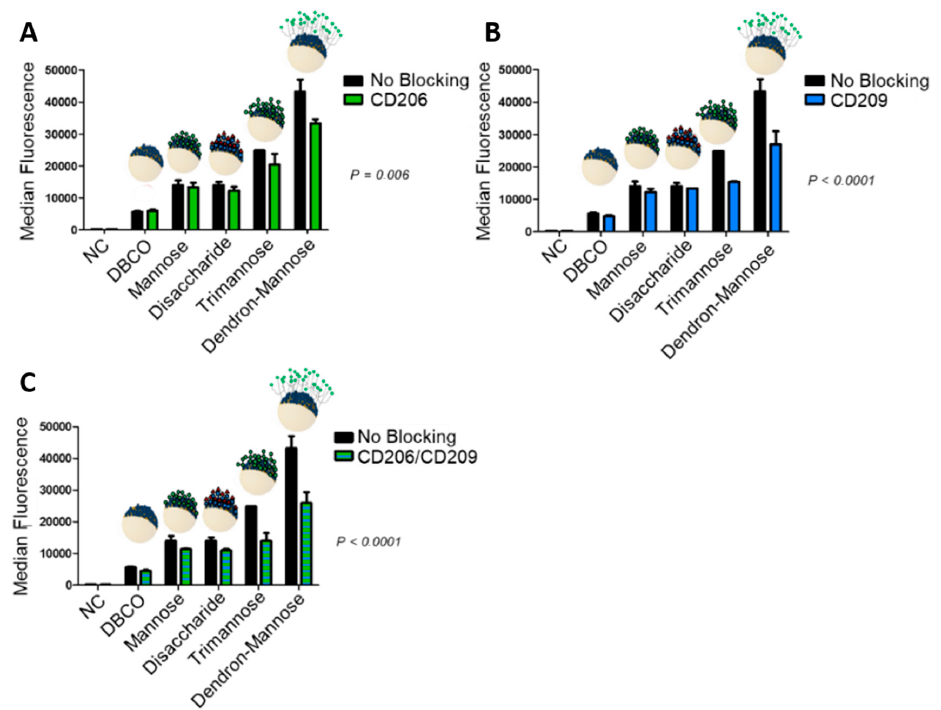
Figure 3. Uptake and blocking experiments of HES nanocapsules, decorated with carbohydrates into human dendritic cells (hDCs) in three different experimental setups. The experiments were performed in duplicates using ANOVA for data evaluation with a p -value = 0.006 ( A ), p -value < 0.0001 ( B ) and p -value < 0.0001 ( C ).